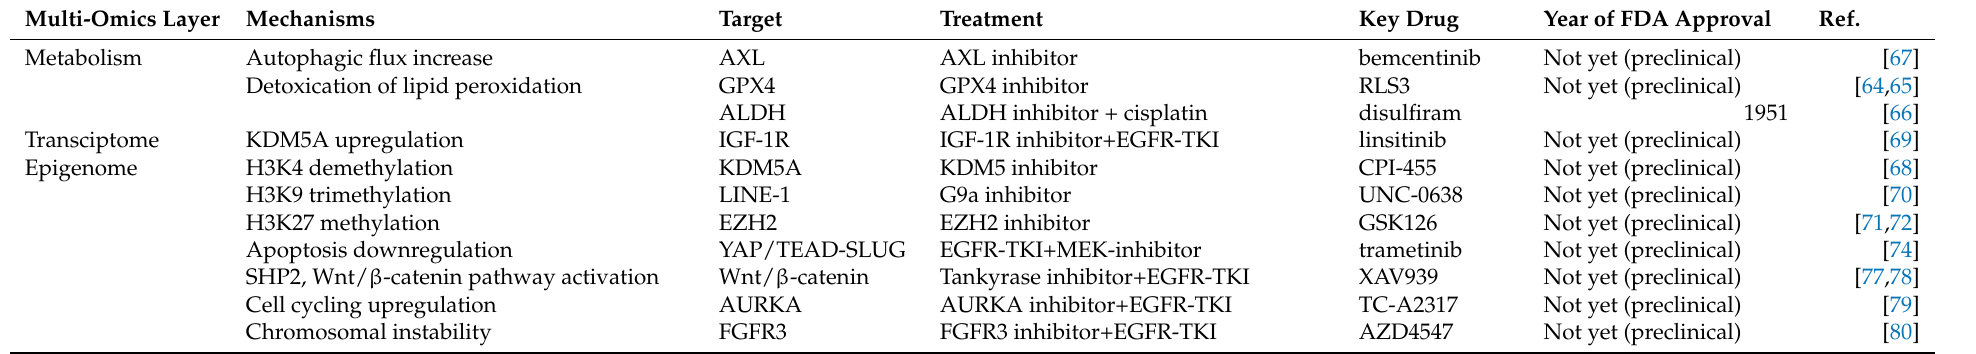
Table 1. DTP cell-specific resistance mechanisms and